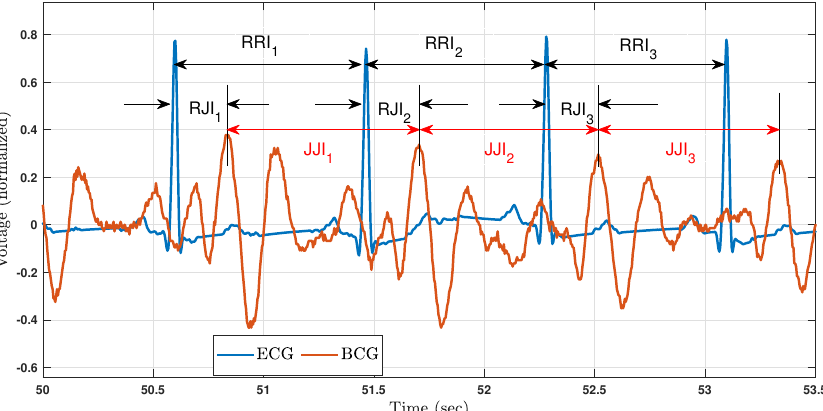
Figure 1. Heartbeat interval estimates from simultaneous ECG and BCG recordings. An R − R interval (RRI) represents the time between consecutive R peaks—the prominent peaks of an ECG that correspond to the onset of ventricular depolarization events. Similarly, a J − J interval (JJI) represents the time between consecutive BCG J peaks, where J peaks are the prominent peaks of a BCG, believed to be generated by blood ejection events at the aortic artery. Variations in RJIs due to physiology are also indicated in this figure, labeled as RJI n . Although RJI1, RJI2, and RJI3 are visually similar, they are numerically different. The signal amplitudes are normalized relative to their respective ranges across the entirety of each